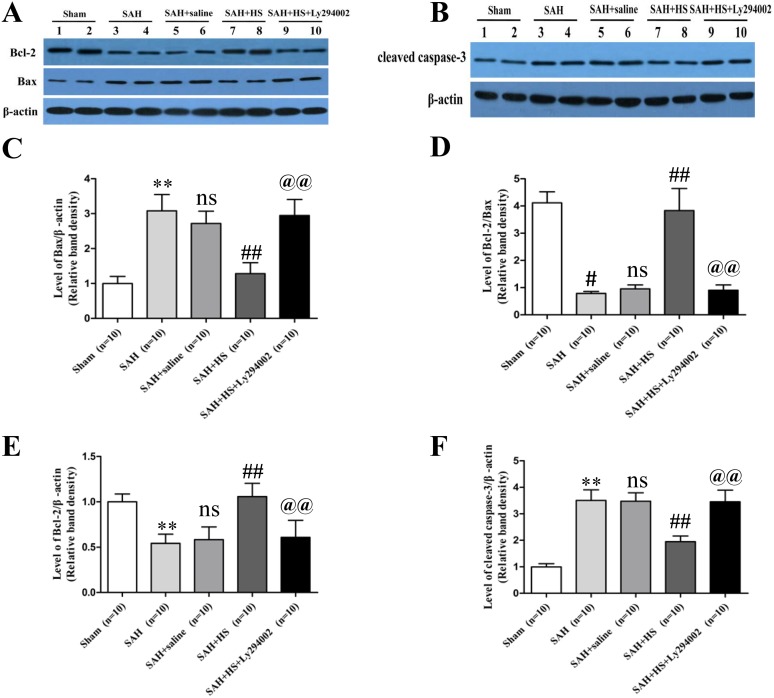
Representative western blots and quantitative analysis of Bcl-2, Bax and cleaved caspase-3 in the left cortex at 24 hours after SAH.The Bcl-2 protein level was significantly up-regulated by HS administration compared with the SAH and SAH + saline groups, which was down-regulated by Ly294002 (P<0.01; Fig. 3A, 3C). The expression of Bax protein in the HS groups showed a markedly decreased level compared with the SAH and SAH + saline groups, which was inhibited by Ly294002 (P<0.01; Fig. 3A, 3D). Moreover, the ratio of Bcl-2 and Bax protein was increased after HS treatment compared with the SAH and SAH + saline groups, and was abolished by Ly294002 (P<0.01; Fig. 3E). The expression of cleaved caspase-3 protein shows a similar trend as the Bax protein (P<0.01; Fig. 3B, 3F). **P<0.01 vs. sham group; ns P>0.05 vs. SAH group; ## P<0.01 vs. SAH + saline group; @@
P<0.01 vs. SAH + HS group.